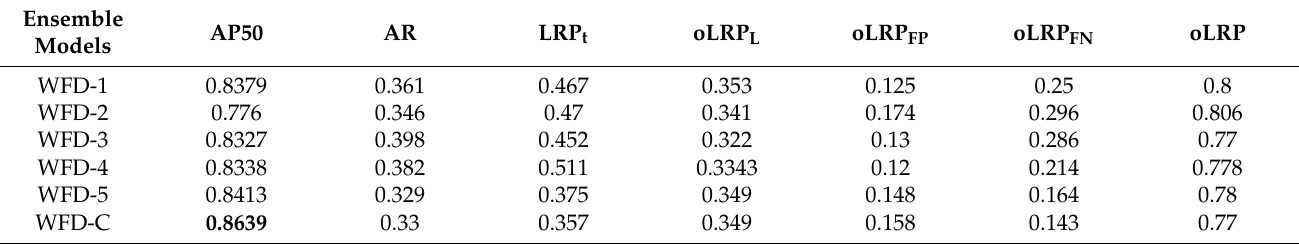
Table 10. Results (AP50, AR, LRP-optimal threshold (LRP t ), oLRP Loc (oLRP L ), oLRP FP and oLRP FN